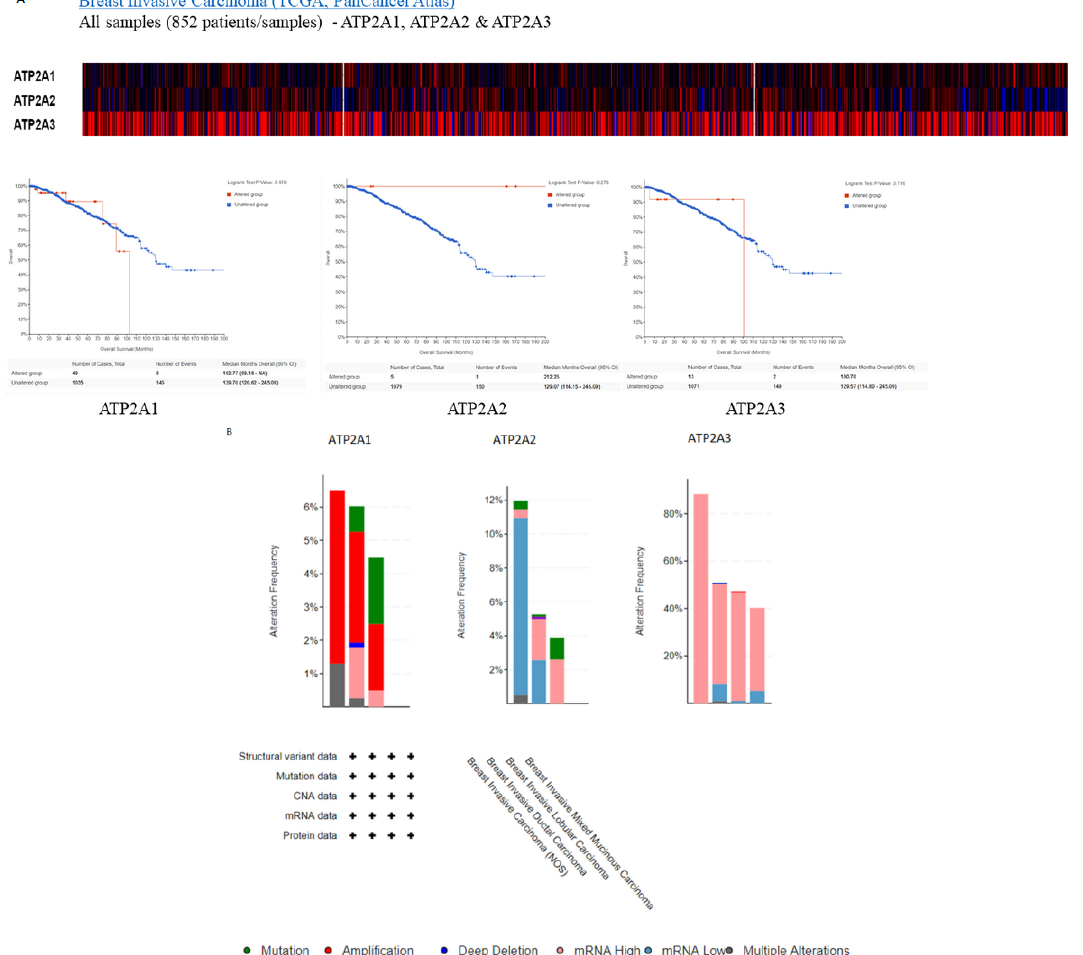
Figure 2. Expressions heatmap of SERCA isoforms in breast cancer patients. Kaplan–Maier plots. ( A ) ATP2A1 KM survival plots with expressions and alterations. p = 0.149. ( B ) ATP2A2 KM survival plots with expressions and alterations. p = 0.455.